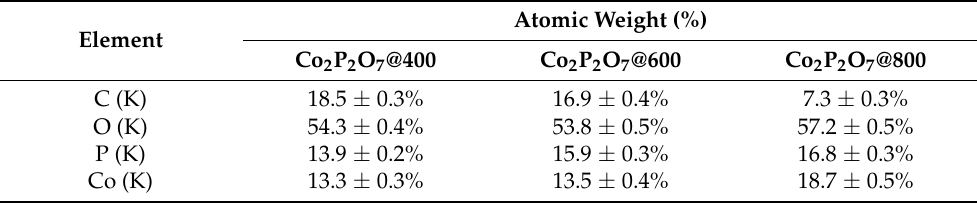
Table 1. Atomic weight (%) of C, O, P and Co in Co 2 P 2 O 7 /CNFs@400, Co 2 P 2 O 7 /CNFs@600